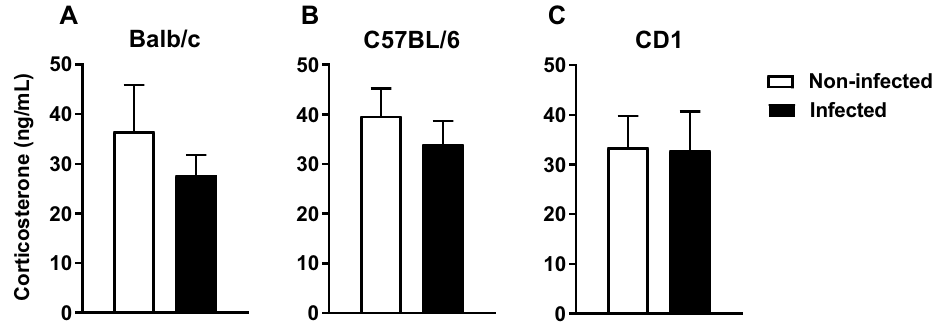
Figure 5. No alterations in basal corticosterone levels were observed in M. avium infected compared to non- infected mice. Basal serum corticosterone levels were measured in Balb/c ( A ), C57BL/6 ( B ) and CD1 ( C ) mice non-infected and infected with M. avium (4wpi). Each bar represents the mean + SEM from 15 to 16 mice per group from 1 of 2 independent experiments.